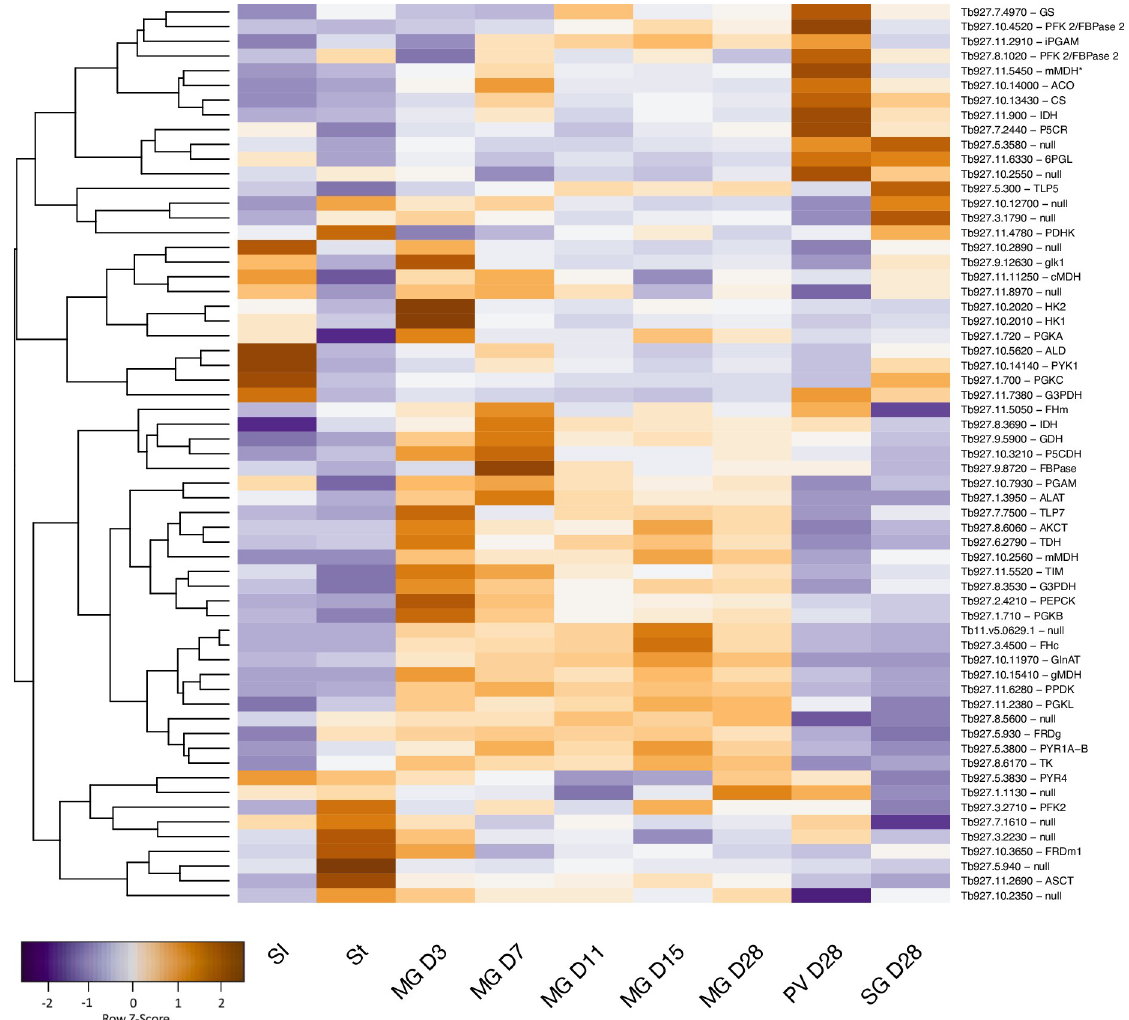
Fig 9. Gene expression heatmap of selected metabolic enzymes. Rows indicate each gene and columns indicate samples. Data were z- score normalised. Colour scale: orange, high expression; blue, low expression. Gene IDs and names are shown. TritrydDB uses the gene name “null” for some genes with putative functions that have not been confirmed